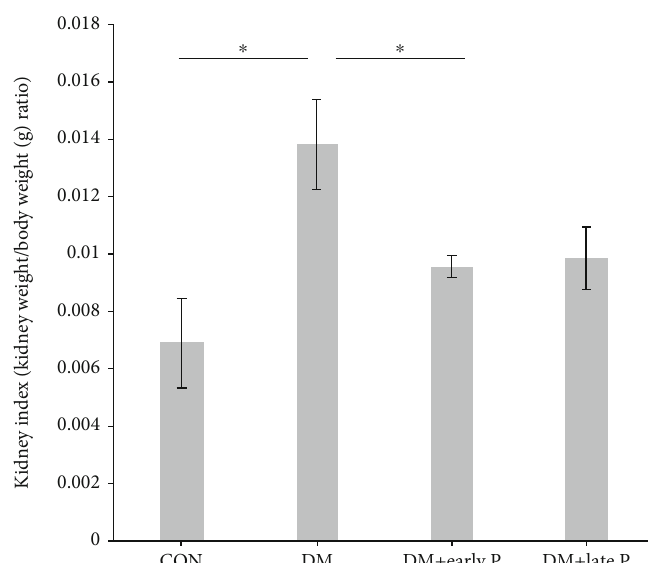
Figure 1: Mouse kidney index. Diabetes induction caused a signi fi cant increase in kidney index levels (DM mice, n = 13 ) as compared to control (CON, n = 9 ) mice ( ∗ p < 0 : 05 ), while paricalcitol treatment (DM+early P ( n = 15 ), DM+late P ( n = 12 )) restored kidney index levels to normal ( p < 0 : 05 , DM+early P mice versus control). Results are expressed as the mean ± SEM .